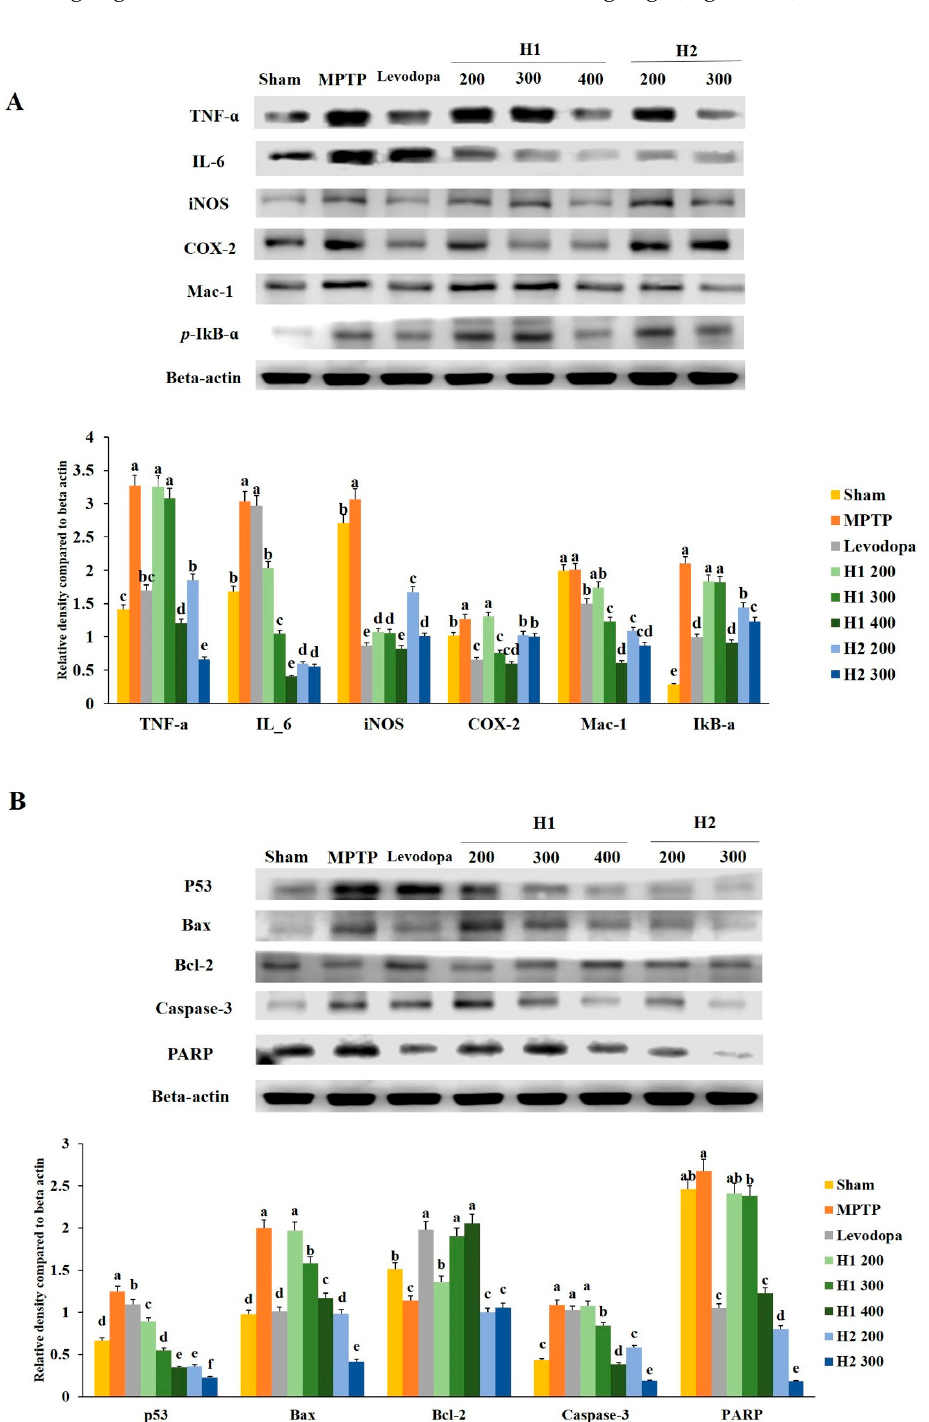
Figure 5. Effects of Hepad 1 (H1) and 2 (H2) (S5) on ( A ) inflammation-related responses and ( B ) apoptotic signaling cascades in 1-methyl-4-phenyl-1,2,3,6-tetrahydropyridine (MPTP)-treated mice. Protein extracts from brain tissues in each of the different groups were subjected to Western blotting analyses. Results are expressed as the mean ± the standard deviation. Level of statistical significance for a, b, c, d, e, and f is p < 0.05 (Duncan’s multiple range test). Additionally, the expression of IL-6 protein, which is an inflammation-related protein, was significantly elevated in MPTP-intoxicated vs. sham mice; however, this increased expression was